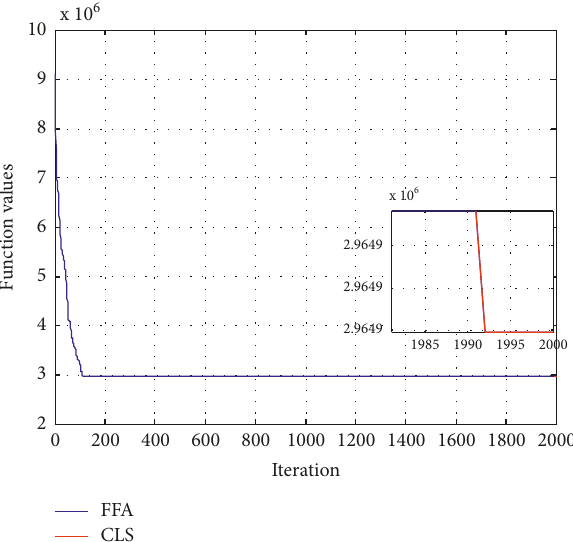
Figure 8: CFFA ′ s convergence curve of gas transmission compressor design problem before and after CLS.